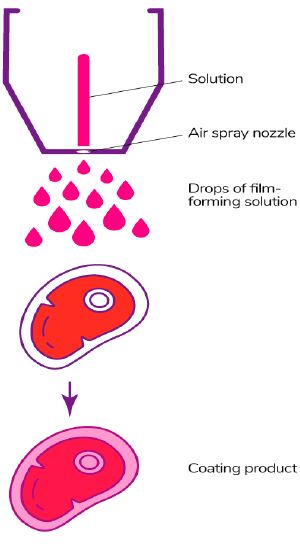
Figure 15. Spraying